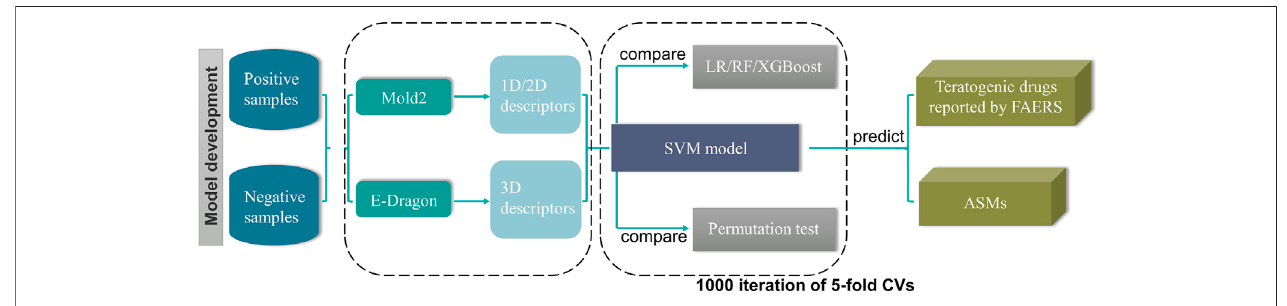
FIGURE 1 | The work fl ow of our study.